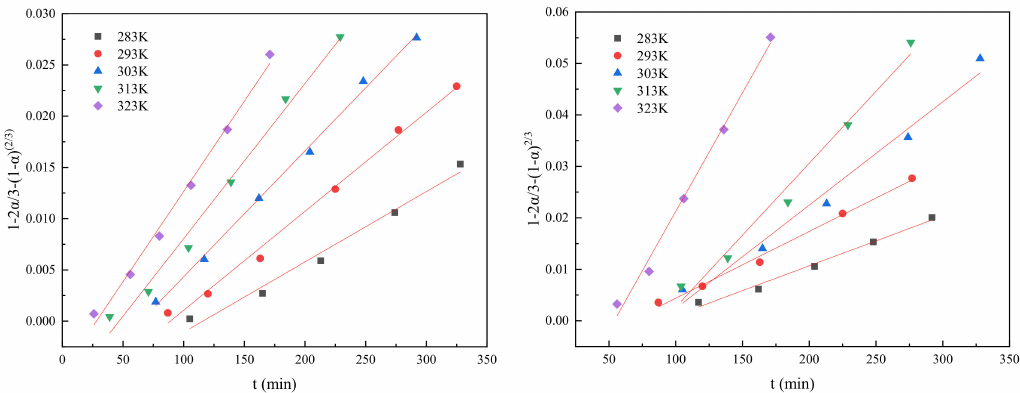
Figure 12. The fitting curve of internal di ff usion control model and